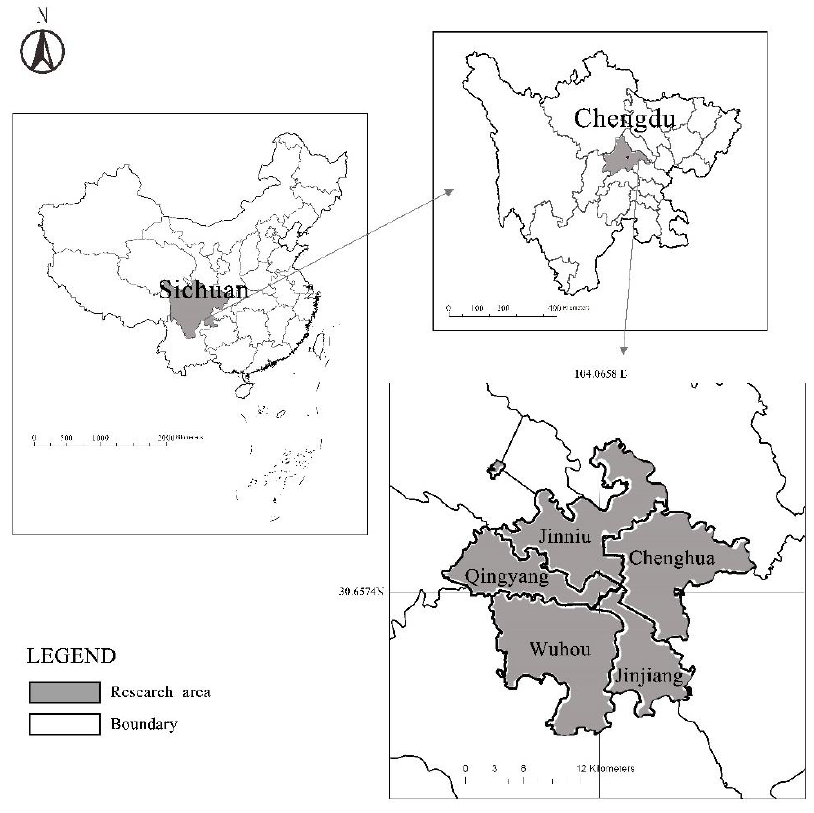
Figure 1. Location of the study area.